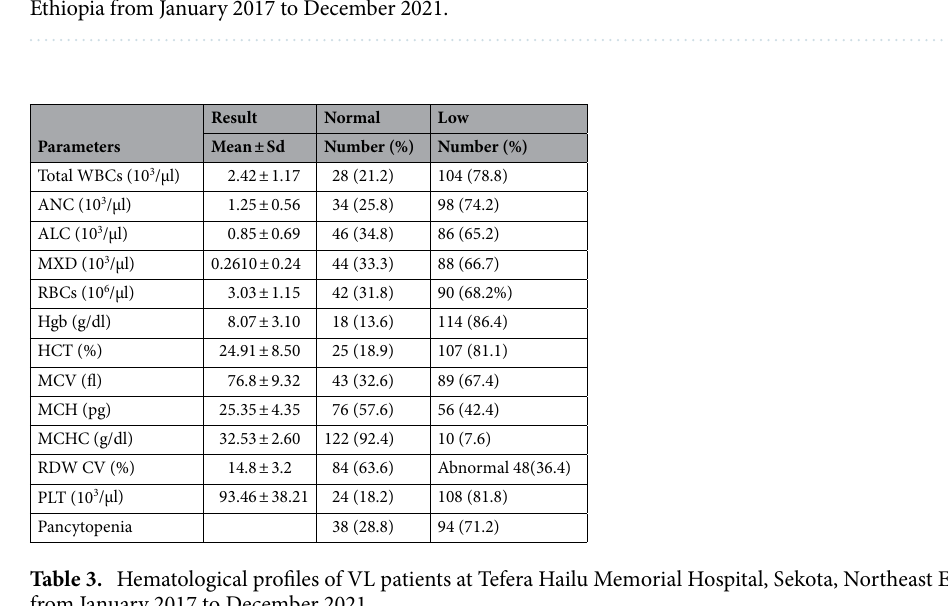
Figure 5. The rate of coinfection in VL patients attending at Tefera Hailu Memorial Hospital, Sekota, Northeast Ethiopia from January 2017 to December 2021.